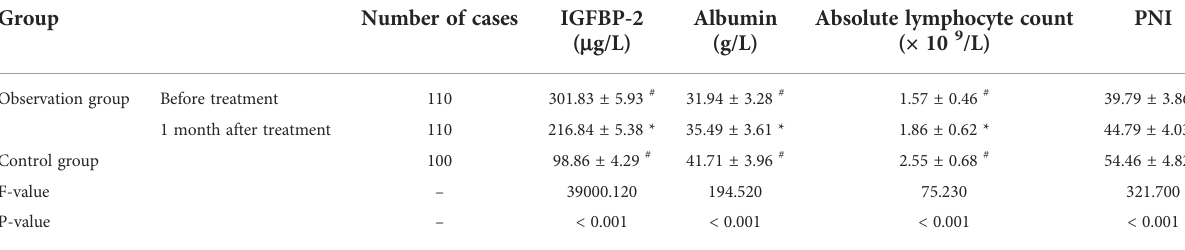
TABLE 2 Comparison of IGFBP-2, albumin, absolute lymphocytes, PNI values [x ̅ ±